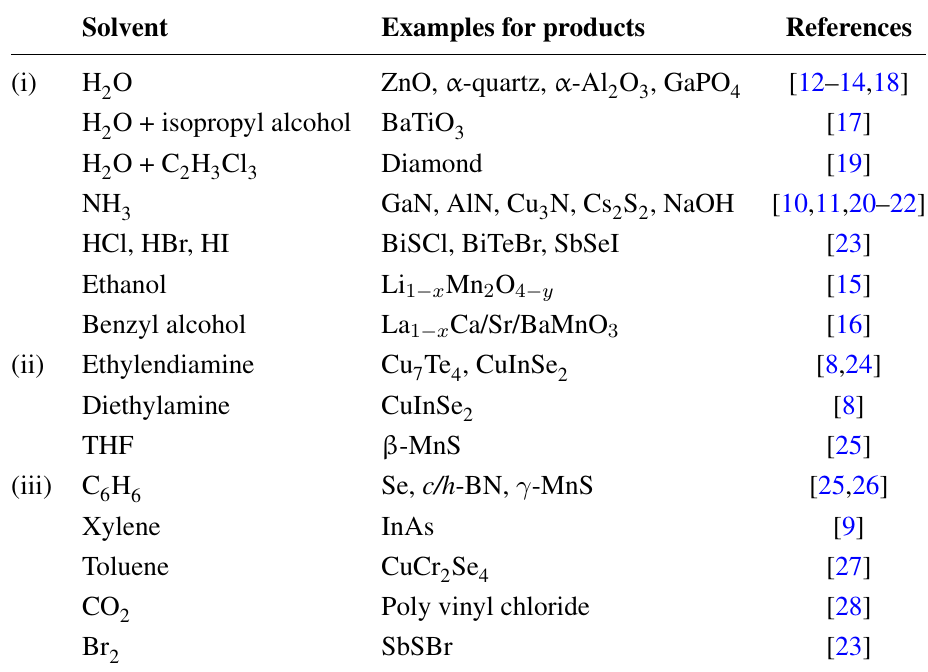
Table 1. Examples for solvothermal solvents and obtained products (see text). Solvent Examples for